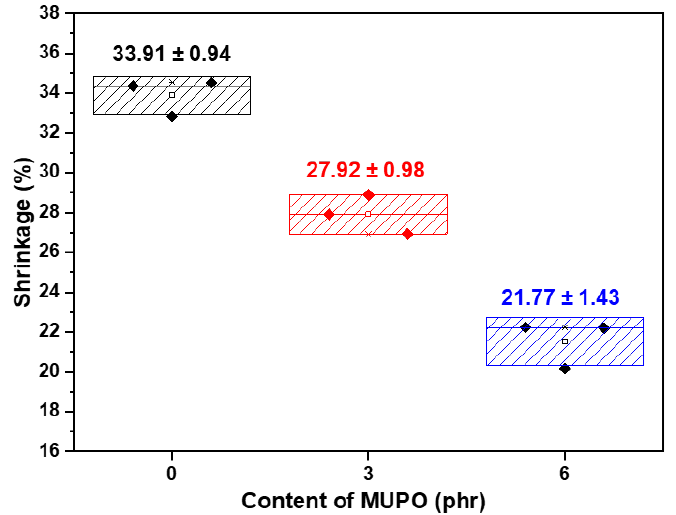
Figure 2. The shrinkage percentage of non-glutinous starch foam with various mUPO content—0, 3, and 6 phr.